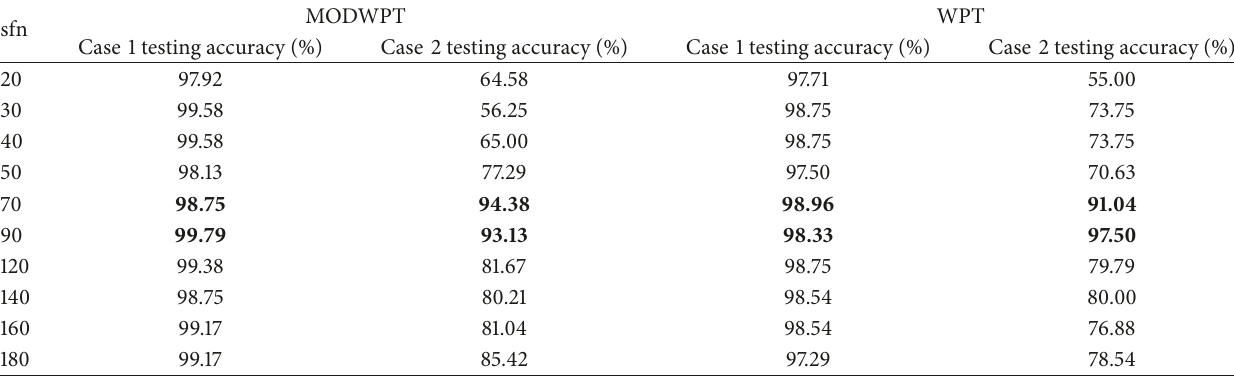
Table 10: Bearing fault diagnosis results obtained by OFS-FSASD-NPE-SVM (dimension size is 20). sfn